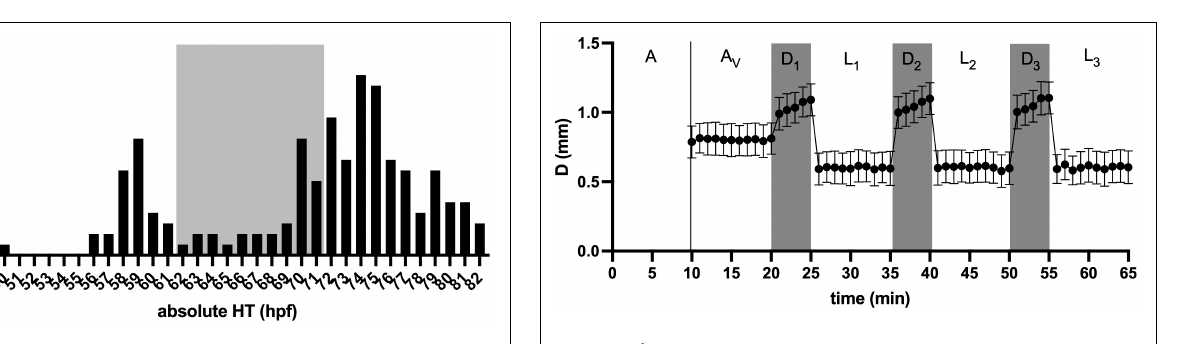
FIGURE 2 | The Histogram of larvae hatched within an observation window between 48 hpf (1 hZT at 2 dpf) and 82 hpf (12 hZT at 3 dpf) in absolute (relative) hatching time (HT, hpf).